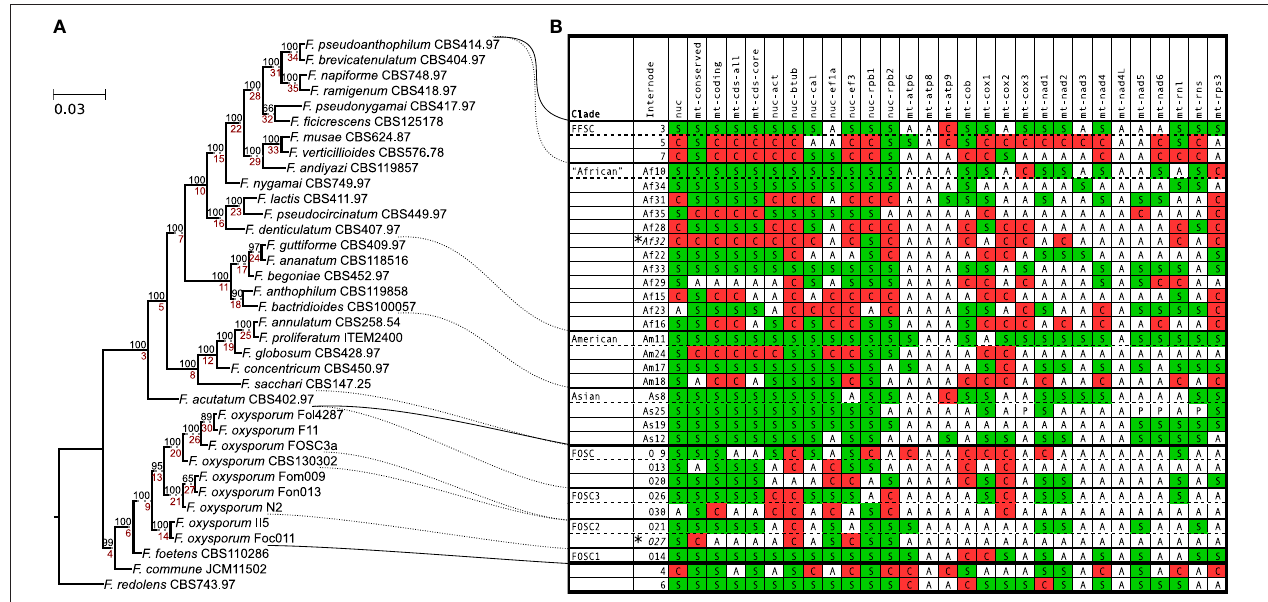
FIGURE 1 | Species tree and internode compatibility with individual trees. (A) Species tree estimated based on the concatenated sequence of the conserved region of the mitocgenome and seven nuclear protein coding genes; bootstrap values are shown above the branches, and internode labels are indicated below the branches (prefixes were added to some internodes based on their taxonomic position). These labels are unique numbers that are referred to by the internode column of the table. (B) The table summarizes the compatibility between the species tree and each of the other trees on internode level (the two internodes with insufficient support in the species tree are marked with asterisks). All insufficiently supported (BS > 70) internodes were removed from the trees. Internode compatibility can be supported (S), absent (A) or conflicted/discordant (C). Internodes are ordered as they appear on the tree with the exception of ones that correspond to major clades. FFSC, F. fujikuroi species complex; The “African” (without F. acutatum ), American & Asian clade of the FFSC; FOSC, F. oxysporum species complex). Column notations: nuc, concatenated nuclear genes; mt-conserved, conserved region of the mitogenome; mt-coding, concatenated coding sequences of the mitogenome (tRNA, rRNA,